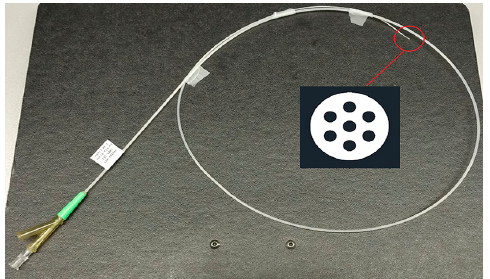
Figure 1. Inhalation catheter (IC 1.1) with a cross section detail of the distal end.